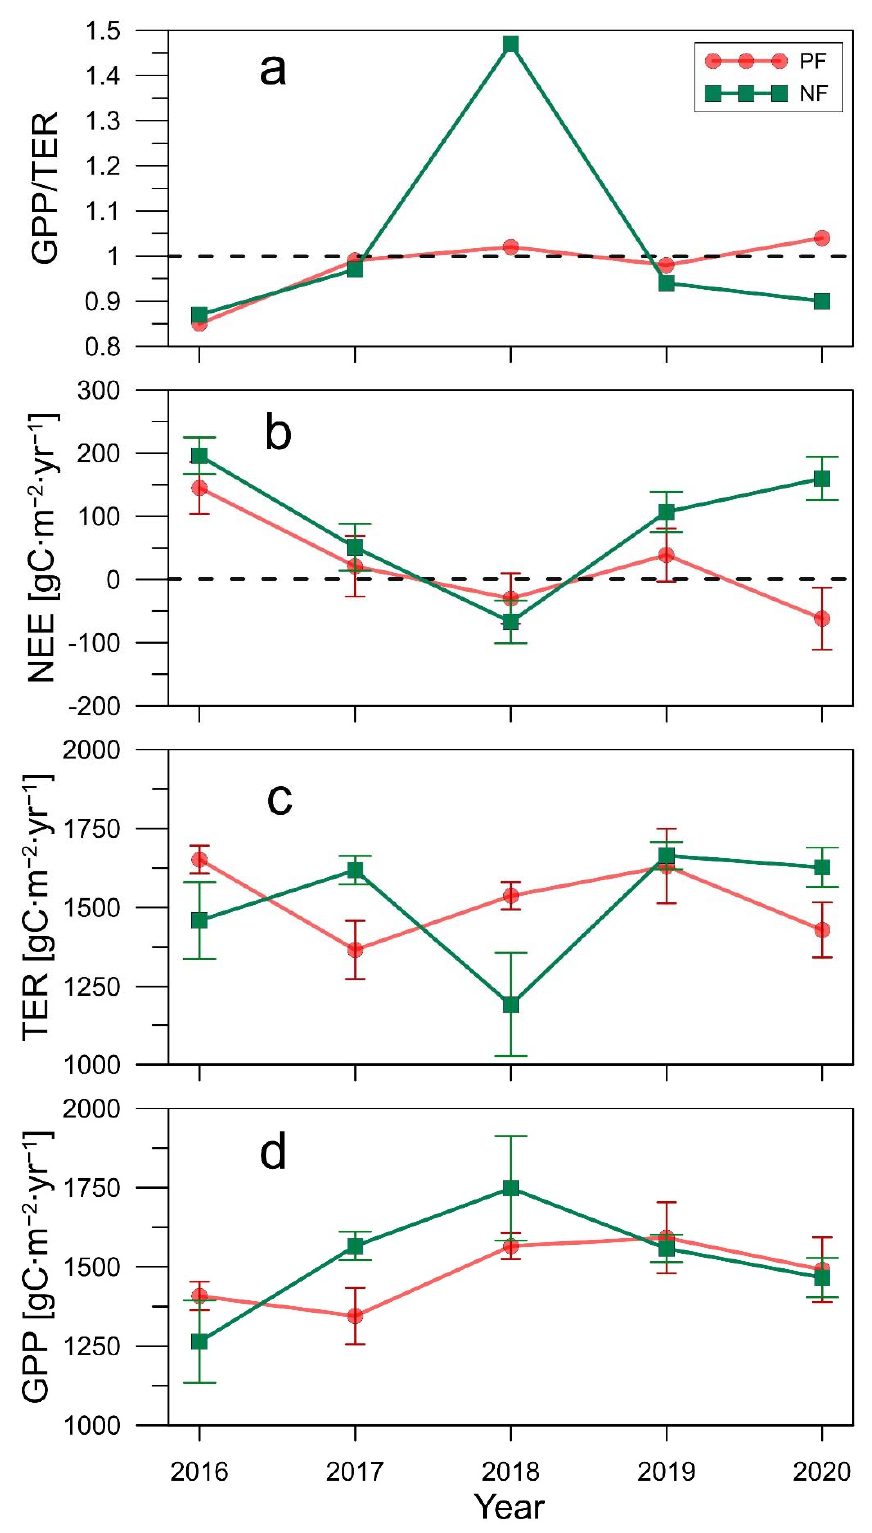
Figure 7. ( a ) Mean annual GPP/TER ratio, ( b ) annual sums of the net ecosystem exchange (NEE), ( c ) total ecosystem respiration (TER) and ( d ) gross primary production (GPP) with the uncertainty estimates associated with random error in the measured fluxes: u*—threshold estimation, gap-filling, and flux partitioning procedures (±SD) in the paludified spruce forest (PF) [51] and the nemorose spruce forest (NF, this study) in the 2016–2020 period.